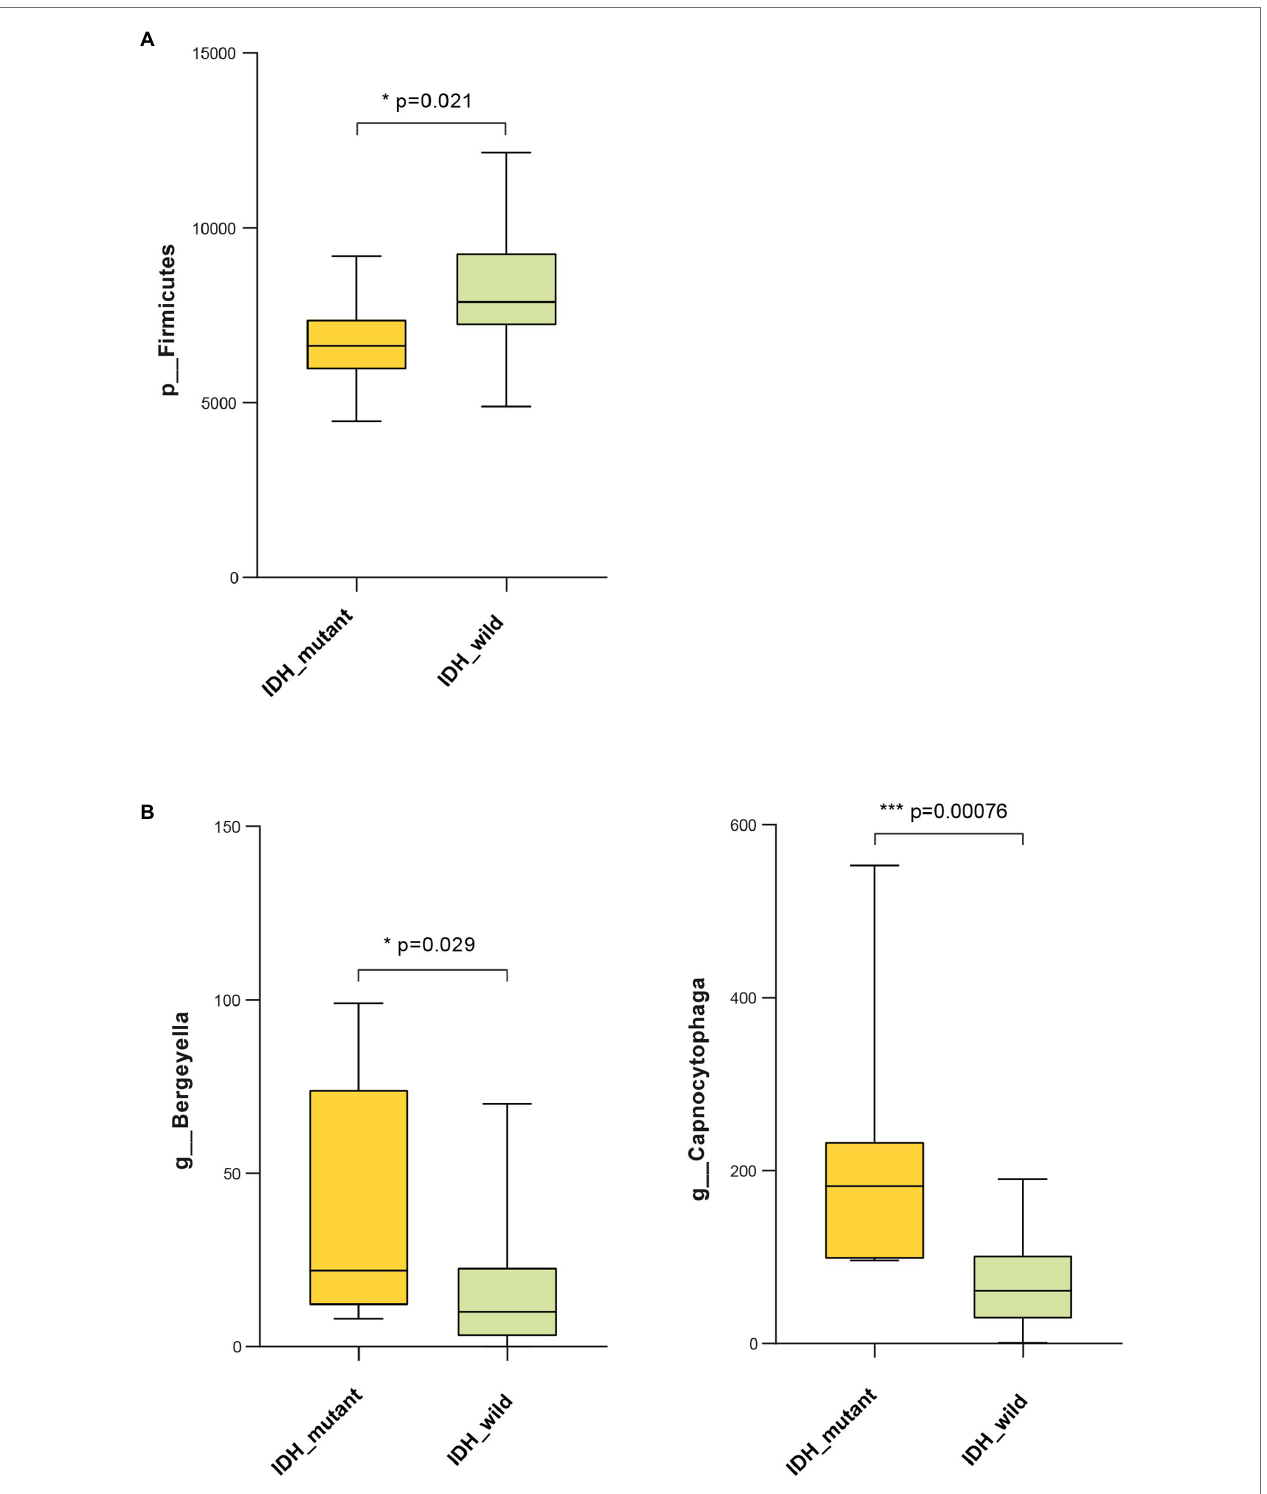
FIGURE 6 | Bacteria taxonomic profiling of oral microbiome from IDH1-mutant group and IDH1-wild group. (A) Relative abundance of phylum Proteobacteria in IDH1-mutant group and IDH1-wild group; (B) relative abundance of genera Bergeyella and Capnocytophaga in IDH1-mutant group and IDH1-wild group. Cross coordinates represent different group names and longitudinal represent the abundance of a species in different groups. The p value was calculated by non-parametric Mann-Whitney U test. Each box plot represents the median, interquartile range, minimum, and maximum values. IDH1, isocitrate dehydrogenase